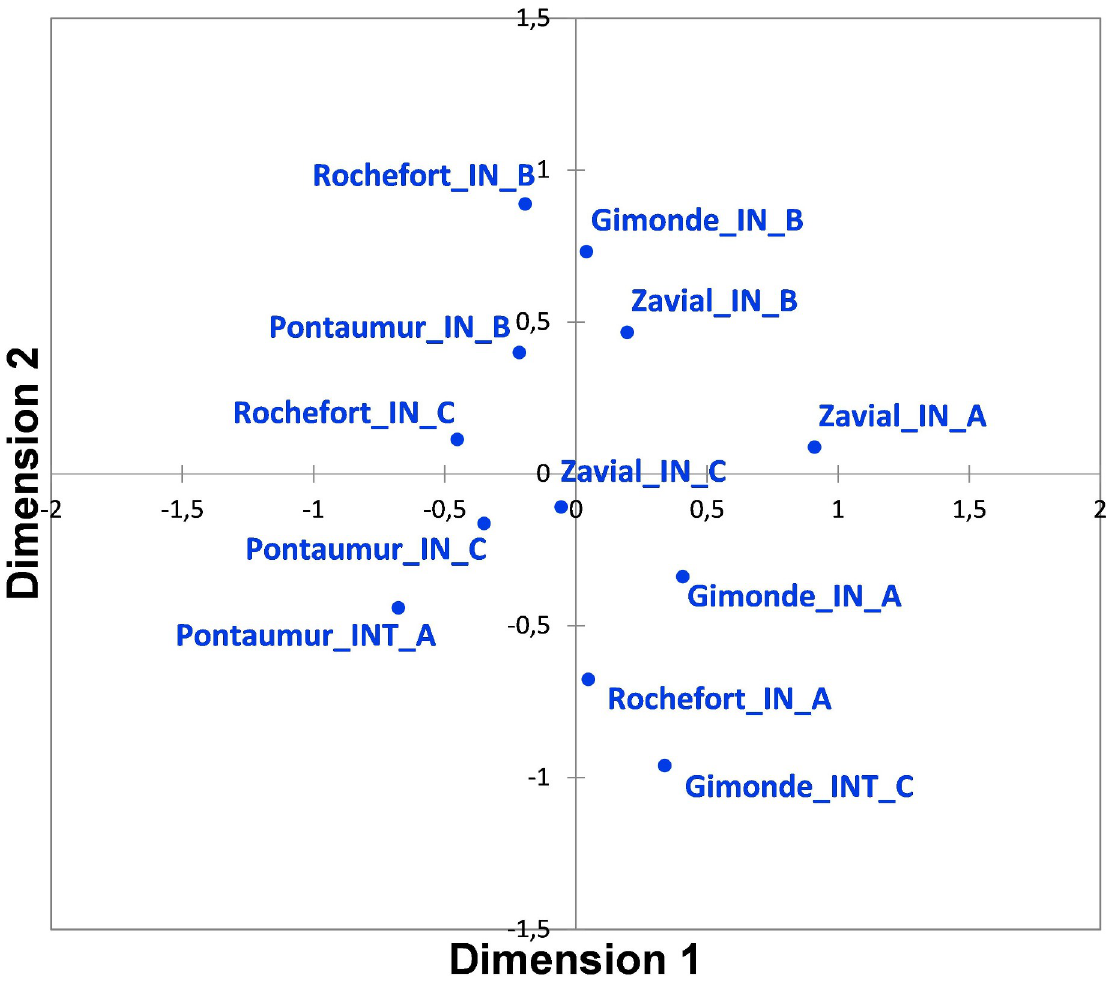
Fig 5. MDS graph resulting of the analysis done with the matrix of dissimilarities (distance measure: Euclidian) for RH levels measured in hives of the four conservation centers over a complete year for each iButton (A, B, C).